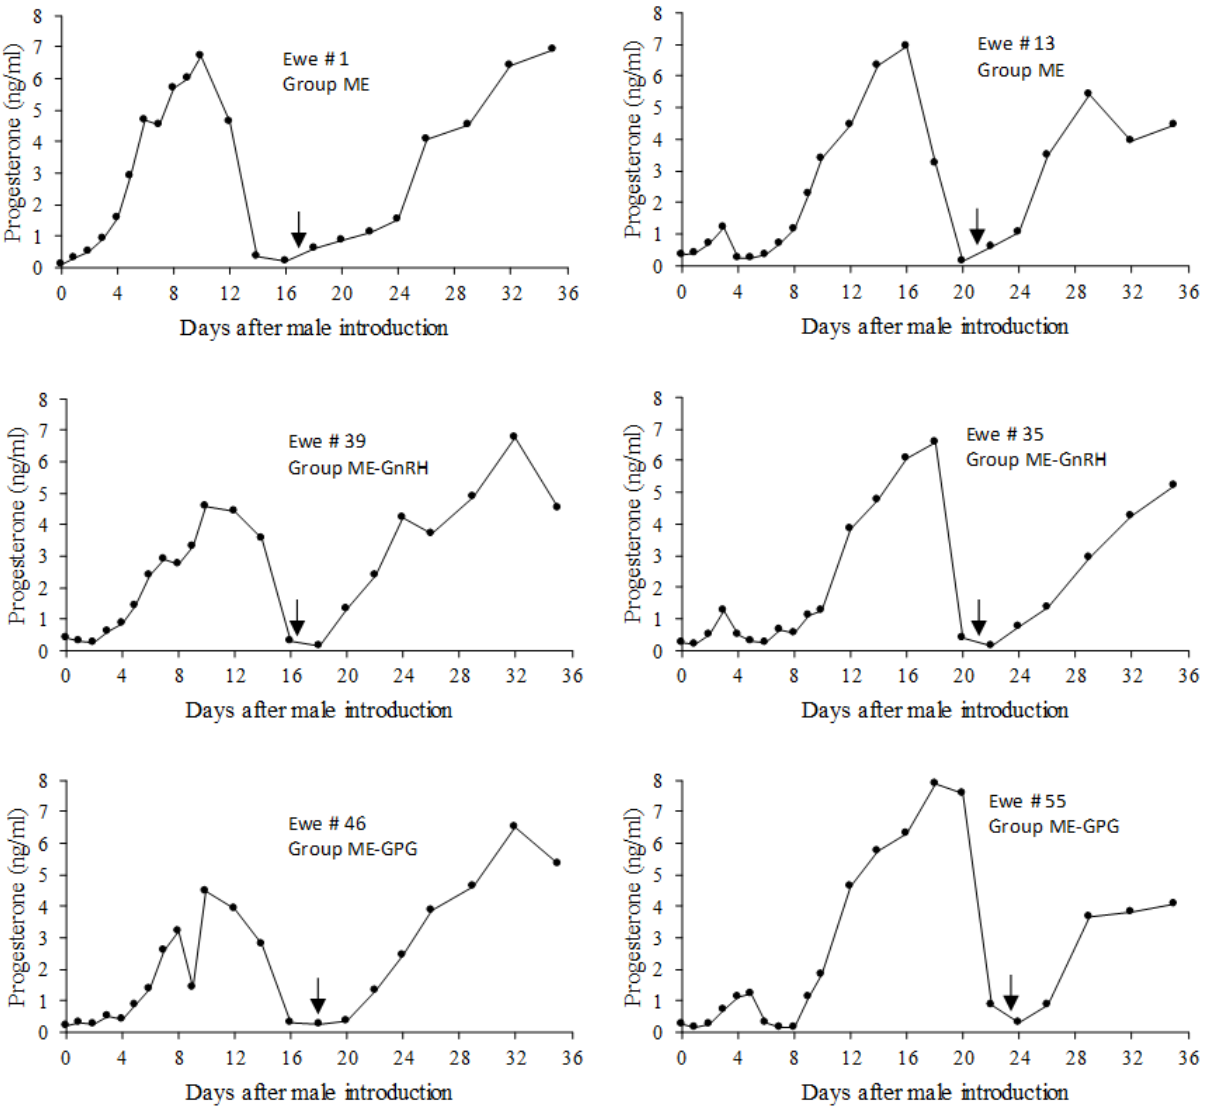
Figure 5. Representative progesterone profiles of ewes that responded to the treatments with a normal-length first cycle (left column) or with a short first cycle (right column) in each experimental group. Arrows indicate the onset of estrus expression. Treatments: ME, ewes were exposed from day 0 to 36 to rams of three different breeds that were rotated every 24 h in groups of 4; ME-GnRH, in addition of exposure to the males the ewes were treated with 4.2 μg of GnRH on day 2; ME-GPG, in addition of exposure to the males the ewes were treated with 4.2 μg of GnRH on day 2, 10 mg of PGF2 α on day 8 and 4.2 μg of GnRH on day